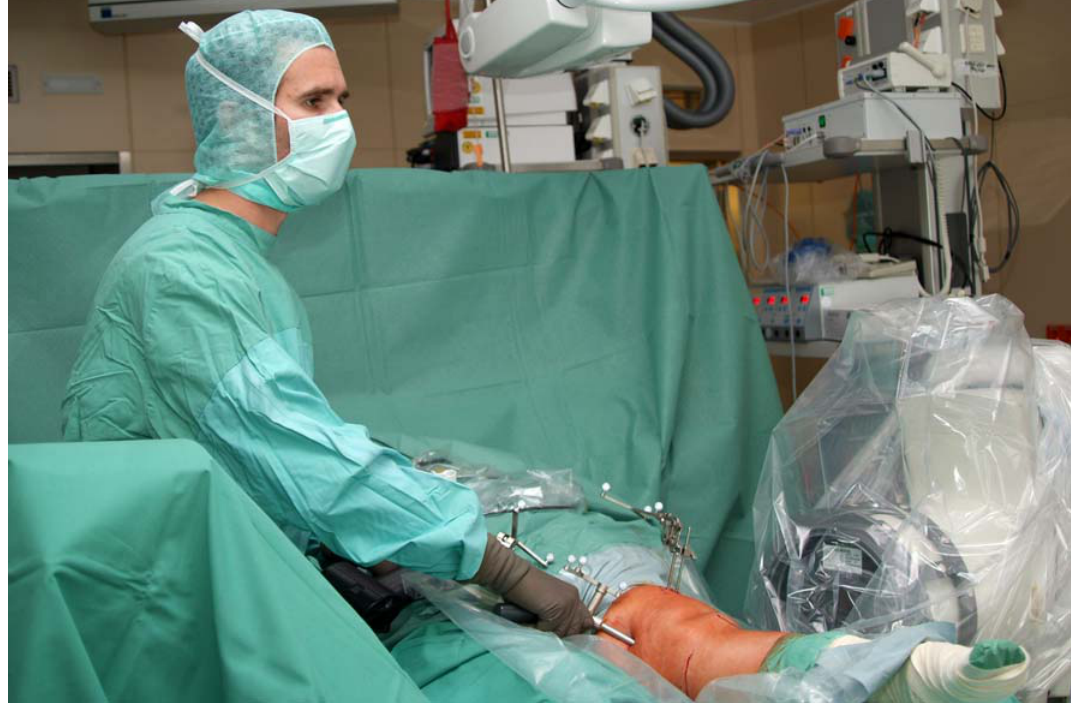
Fig. 2 Intraoperative setup for 3D fluoroscopy-based drilling of an osteochondral lesion of the femur condyle. A navigated drill combined with a navigated drill sleeve allow for an accurate positioning of a 3.2-mm drill bit. The reference marker is fixed to the distal